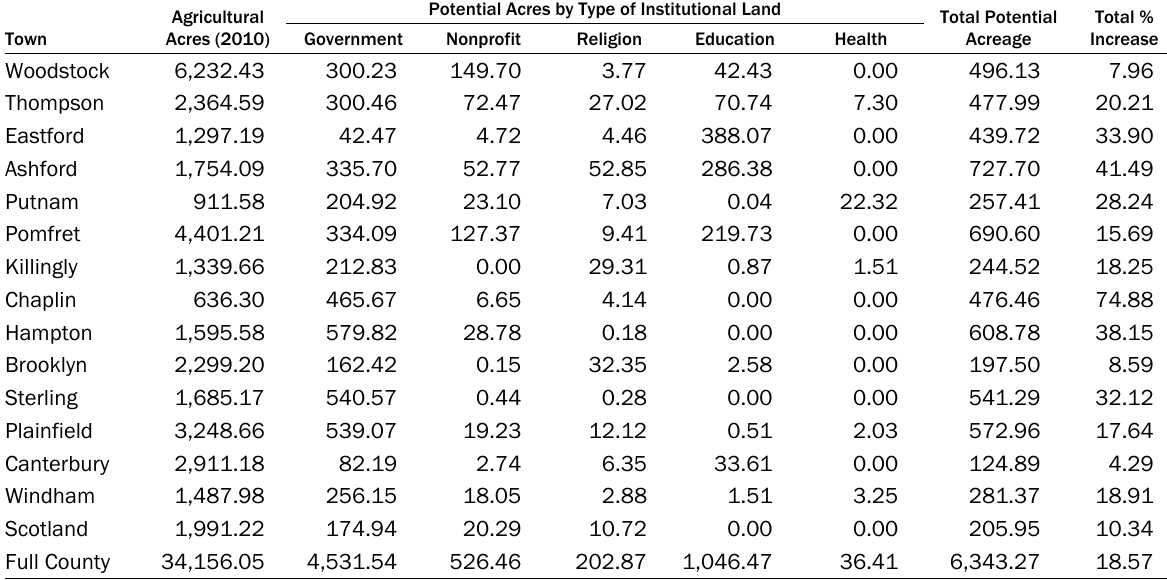
Table 1. Potential Increases in Agricultural Acreage From Converting Institutional Land in Windham County Institutional lands are categorized by the following ownership types: government, nonprofit, religious organization, educational institution, and healthcare